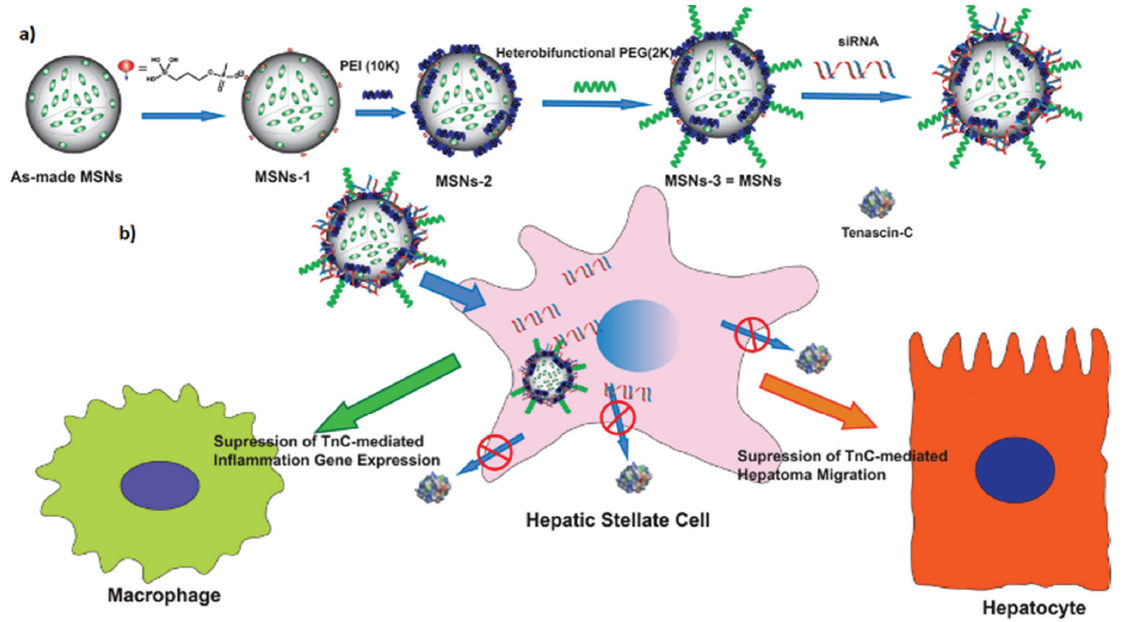
Figure 10. Synthesis of PEG/PEI ‐ coated monodisperse silica microspheres and schematic diagram of siRNA ‐ MSNs carrying, transporting and delivering siTnC and down ‐ regulating TnC protein in hematopoietic stem cells. ( a ) The PEI coated MSNs synthesis. ( b ) The regulation of TnC expression by nano ‐ delivery. Reprinted with permission from Ref. [112]. Copyright 2019 The Royal Society of Chemistry.